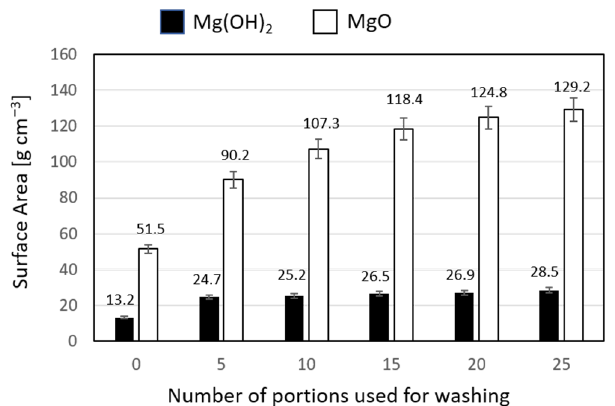
Figure 8. Influence of number of portions of wash water used for washing Mg(OH) 2 obtained from Mg(NO 3 ) 2 and NH 3 (aq) on the specific surface area of magnesium hydroxide and final product.